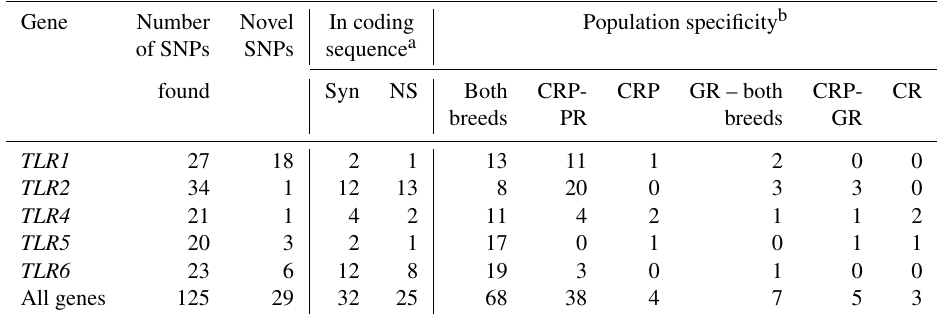
Table 2. Classes of TLR -gene variants found in the Czech Red Pied and Czech Red cattle populations. Gene Number Novel In coding Population specificity b